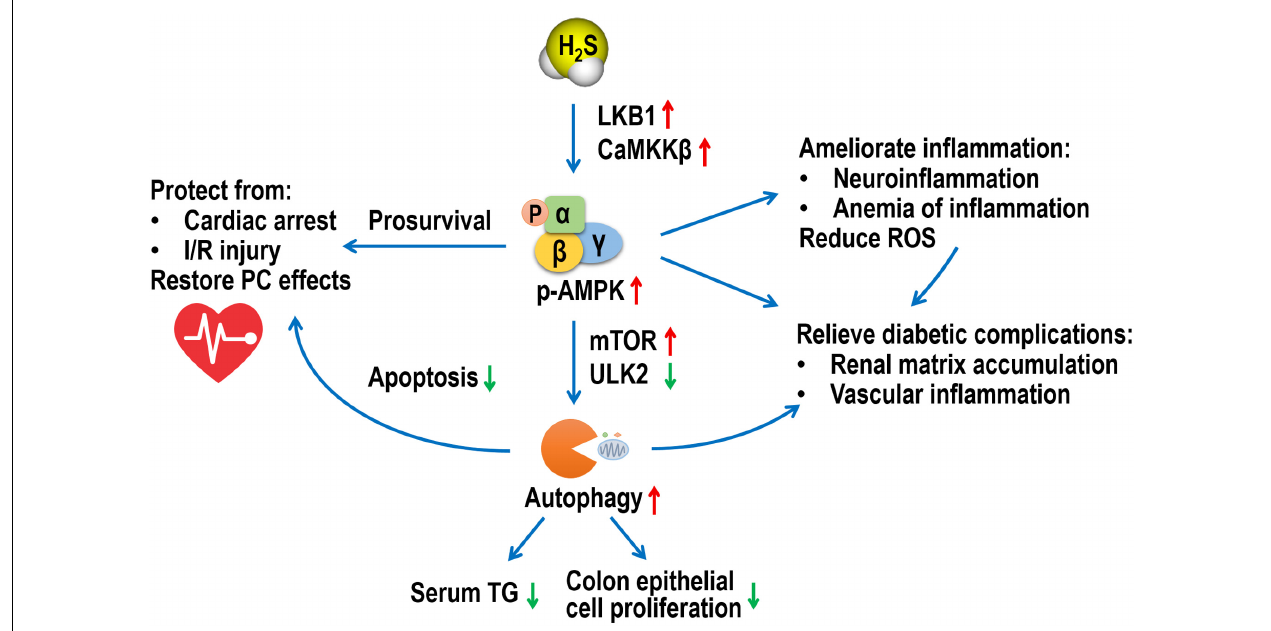
FIGURE 1 | A schematic diagram of multiple roles of AMPK in the pharmacological functions of H 2 S. AMPK, adenosine 5 (cid:48) -monophosphate-activated protein kinase; H 2 S, hydrogen sulfide; LKB1, liver kinase B1; CaMKK β , Ca 2 + /calmodulin-activated protein kinase kinase β ; mTOR, mammalian target of rapamycin; ULK2, UNC-51-like kinase 2; TG, triglyceride; I/R, ischemia/reperfusion; PC, post-conditioning; ROS, reactive oxygen